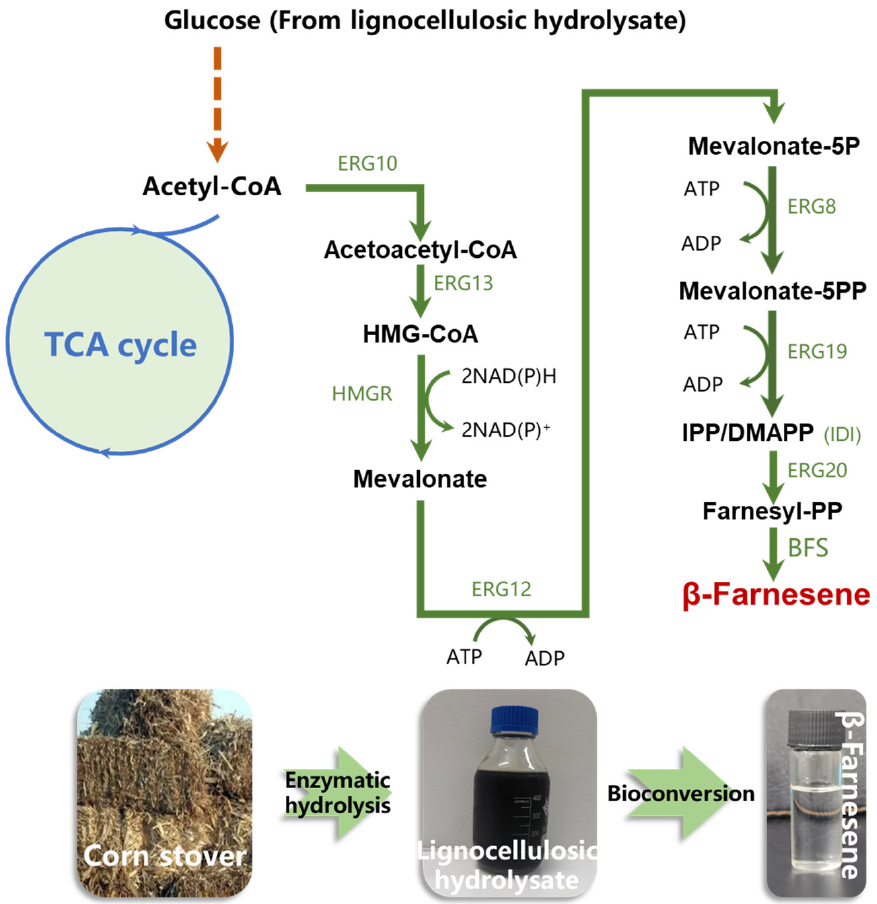
Figure 1. Production of β -farnesene from glucose in lignocellulosic hydrolysate and β -farnesene biosynthesis pathway in engineered Y. lipolytica . Pathway genes are shown in green, and dashed lines represent multi-step reactions. ERG10—acetoacetyl-CoA thiolase; ERG13—hydroxymethylglutaryl- CoA synthase; HMGR—hydroxymethylglutaryl-CoA reductase; ERG12—mevalonate kinase; ERG8— phosphomevalonate kinase; ERG19—mevalonate diphosphate decarboxylase; IDI—isopentenyl diphosphate isomerase; ERG20—farnesyl diphosphate synthase; BFS— β -farnesene synthase; IPP— isopentenyl diphosphate; DMAPP—dimethylallyl diphosphate; TCA—tricarboxylic